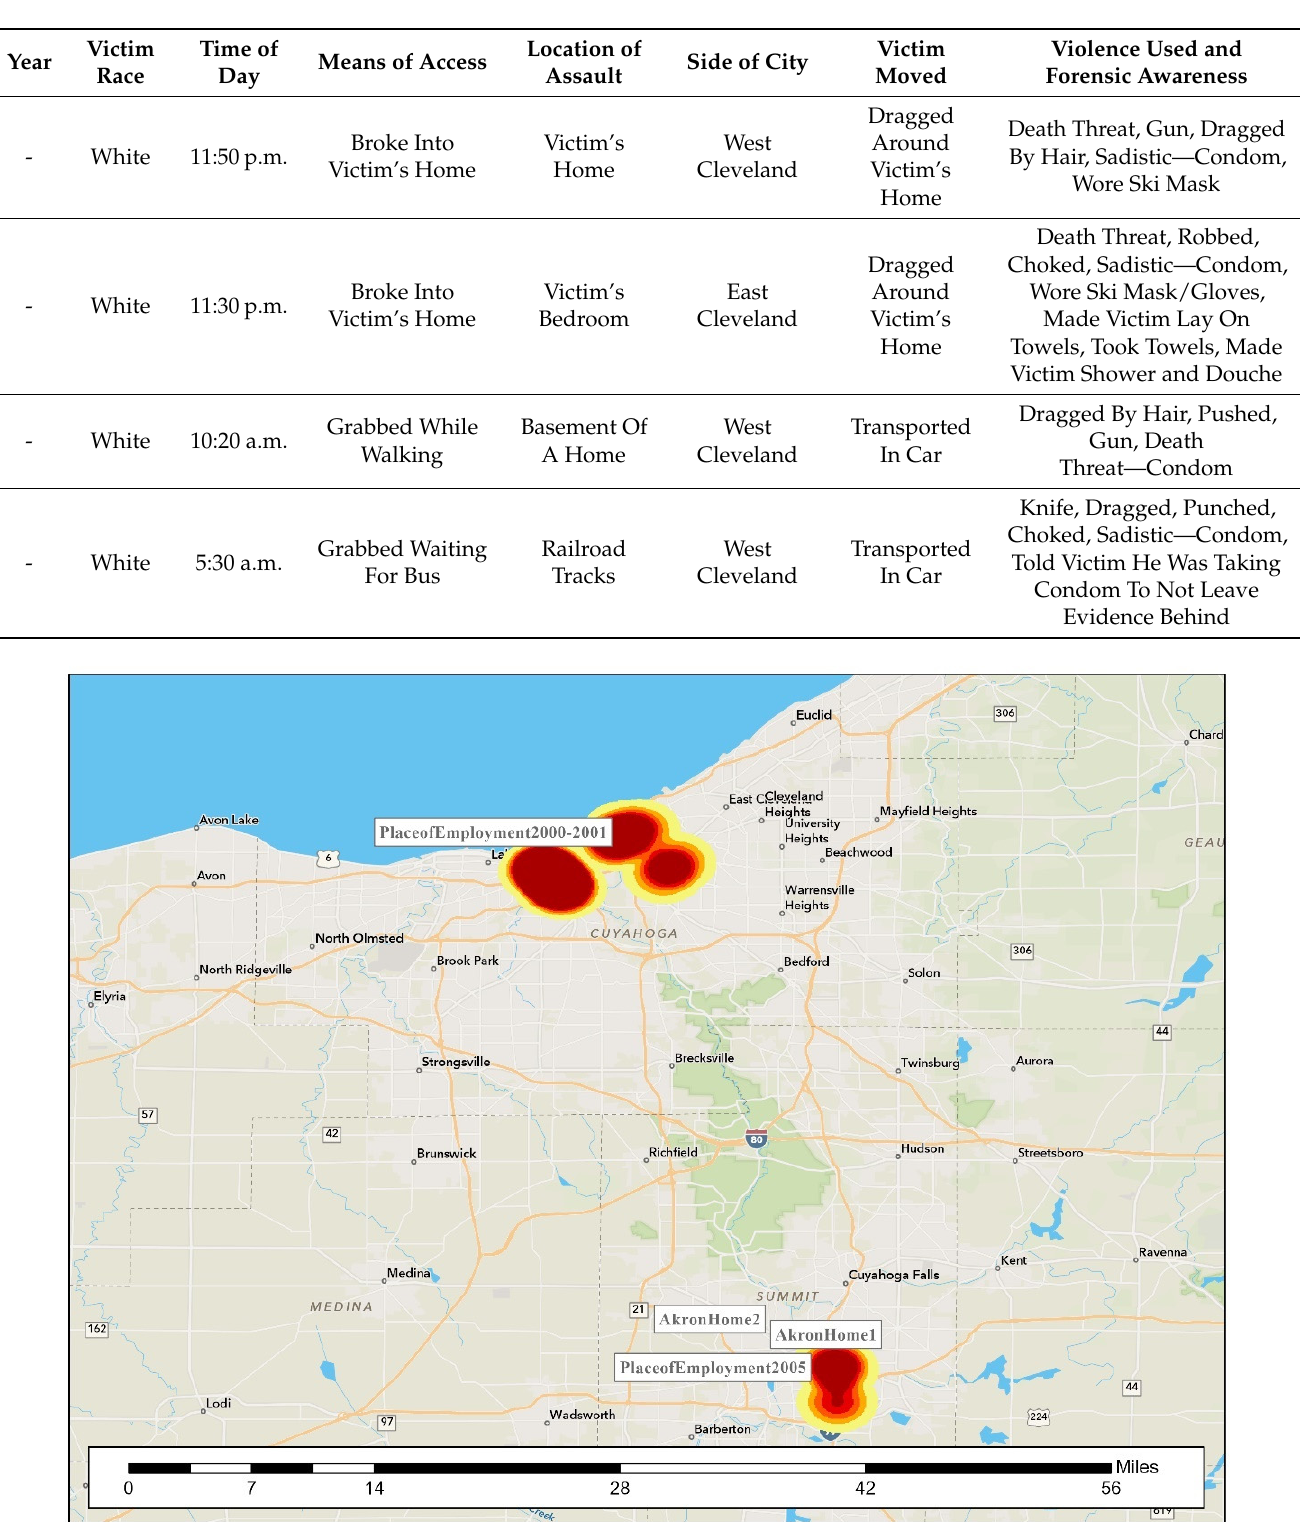
Figure 2. Offender’s Awareness Space, Sexual Assault Heat Map.